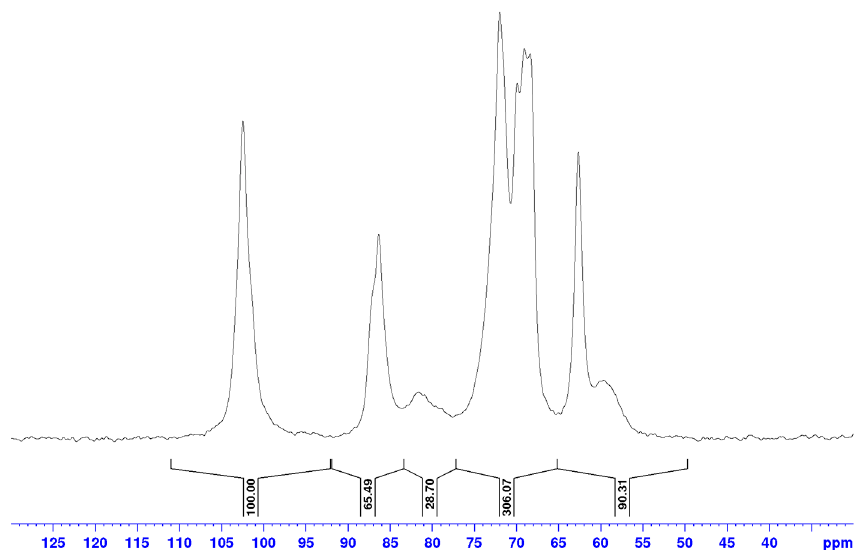
Figure 8. CP-MAS 13 C NMR of BNC-integration.